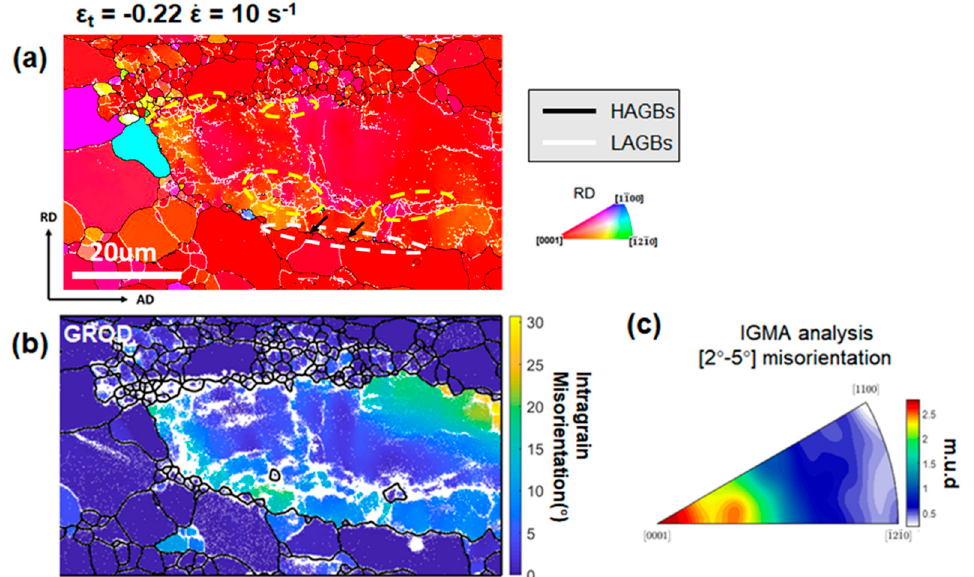
. ε of 10 s − 1 with a step size of